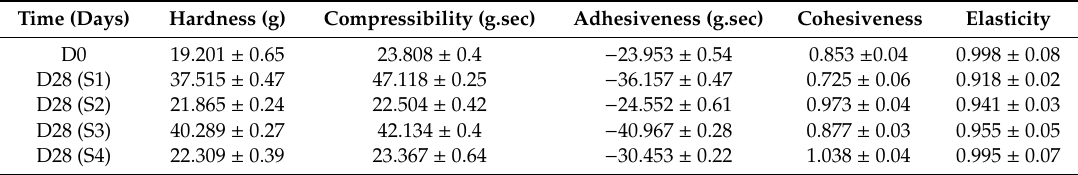
Table 2. Variation of texturometer parameters (hardness, compressibility, adhesiveness,